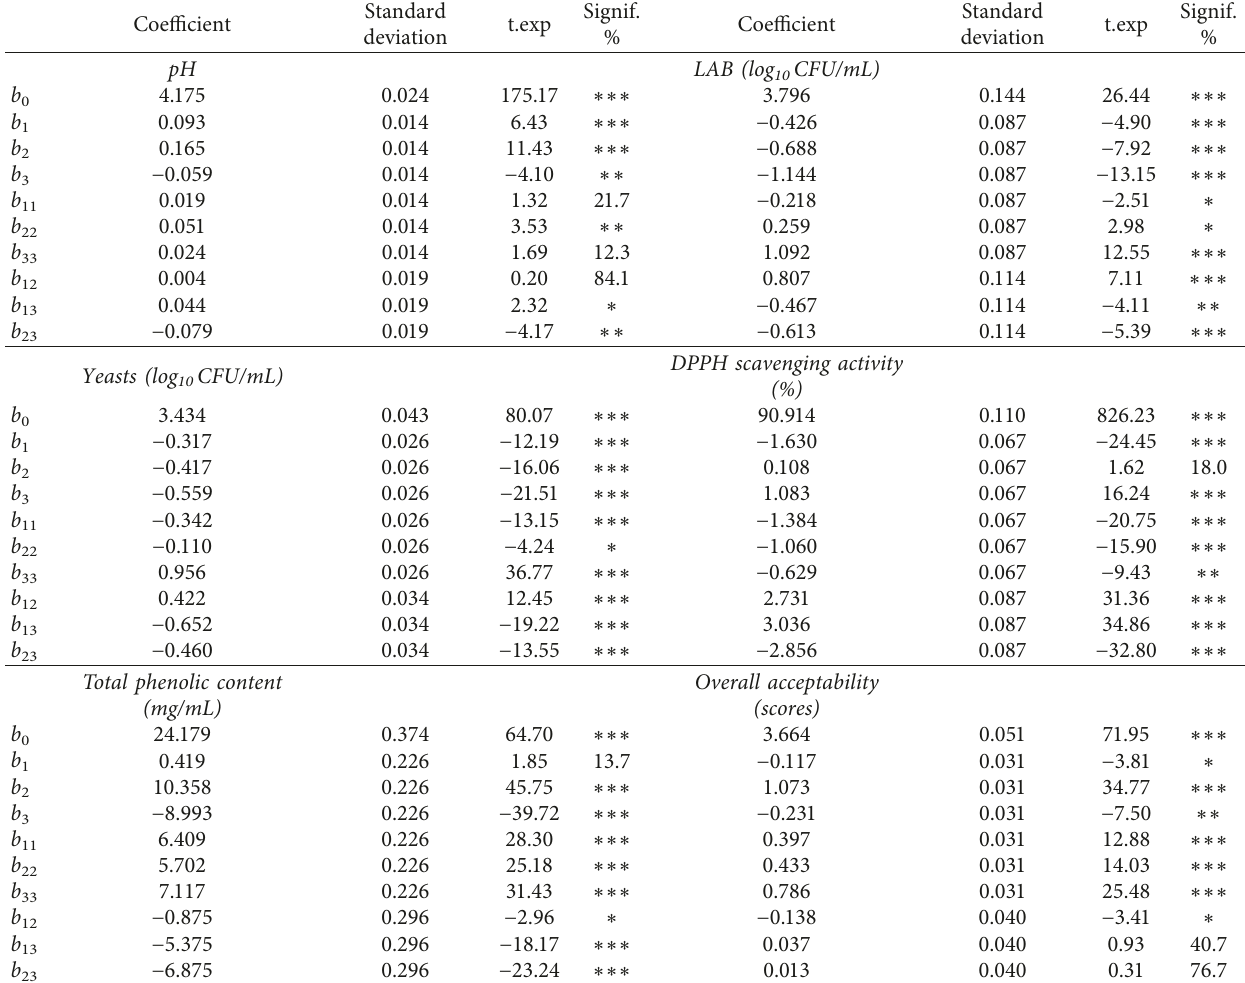
Table 4: Analysis of variance as a linear, quadratic, and interaction for each response variable.